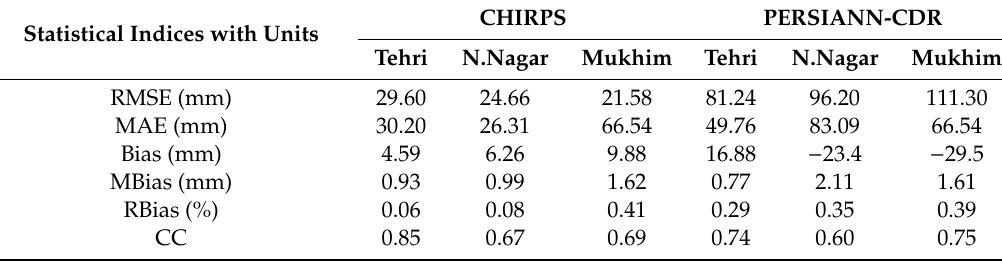
Table 3. Statistical indices to check the spatial similarity between observed and gridded datasets (CHIRPS and PERSIANN-CDR) for the period from 1983 to